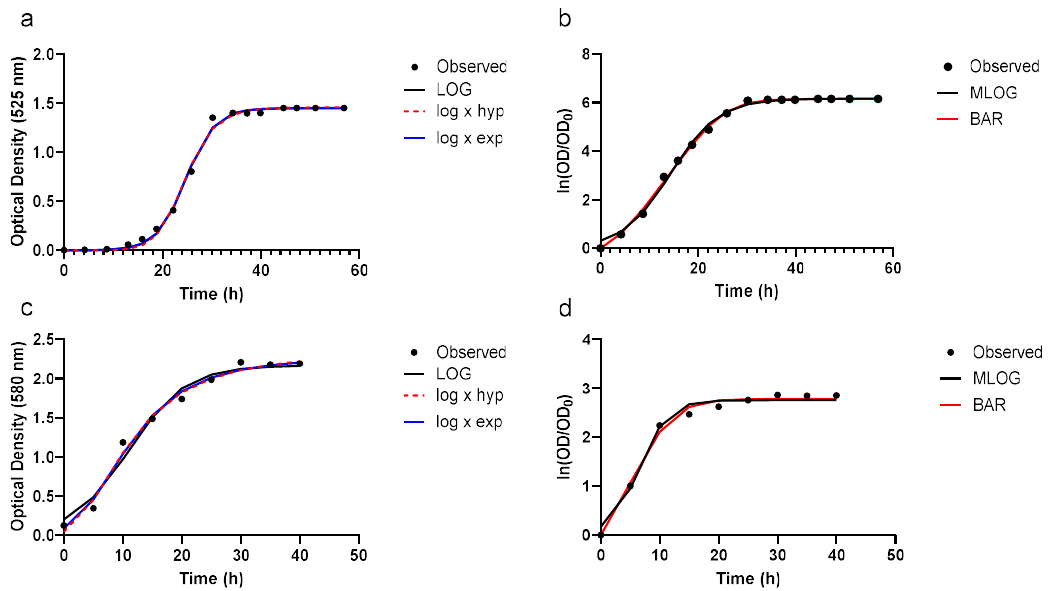
Figure 1. Optical density growth data and model predictions for Flavobacterium psychrophilum . Growth predictions using ( a ) LOG, log × hyp, log × exp and ( b ) MLOG and BAR, grown on a TYES liquid medium, and ( c ) LOG, log × hyp, log × exp and ( d ) MLOG and BAR, grown on a FLBP liquid medium. In panels ( a ) and ( c ), models are fitted to untransformed optical density measurements (OD) while ( b ) and ( d ) models are fitted to [ln(OD/OD 0 )].